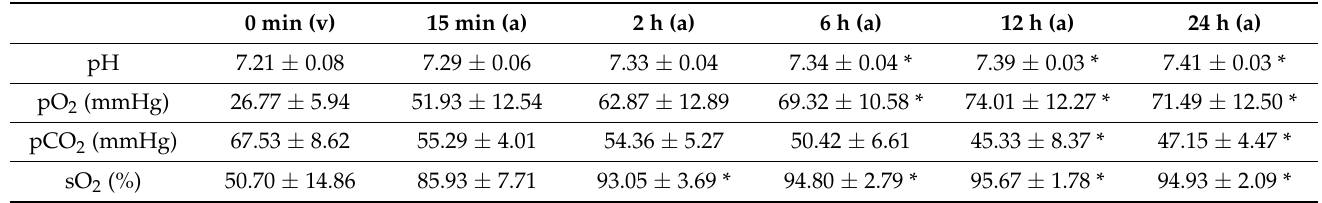
Table 1. Means and standard deviations of the blood gas variables pO 2 (partial pressure of oxygen), pCO 2 (partial pressure of carbon dioxide), and sO 2 (oxygen saturation) in 20 neonatal calves in the first 24 h of life. Within rows, values with an asterisk differ significantly from the 15 min value. v, venous; a, arterial.